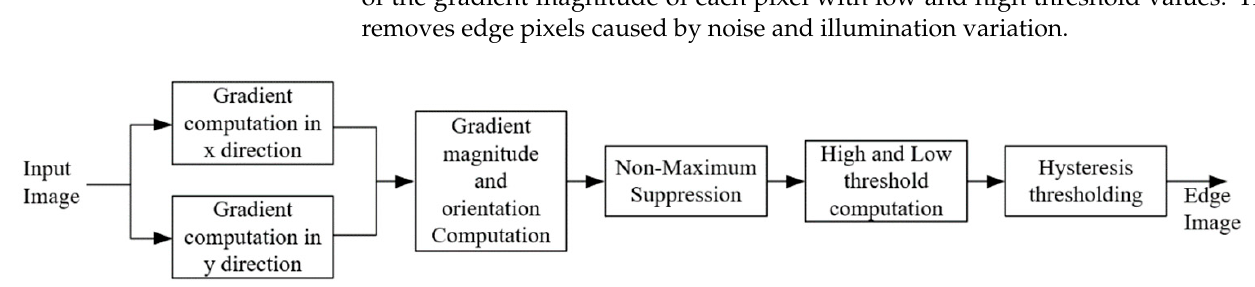
Figure 1. Block diagram of the Canny edge detection algorithm.